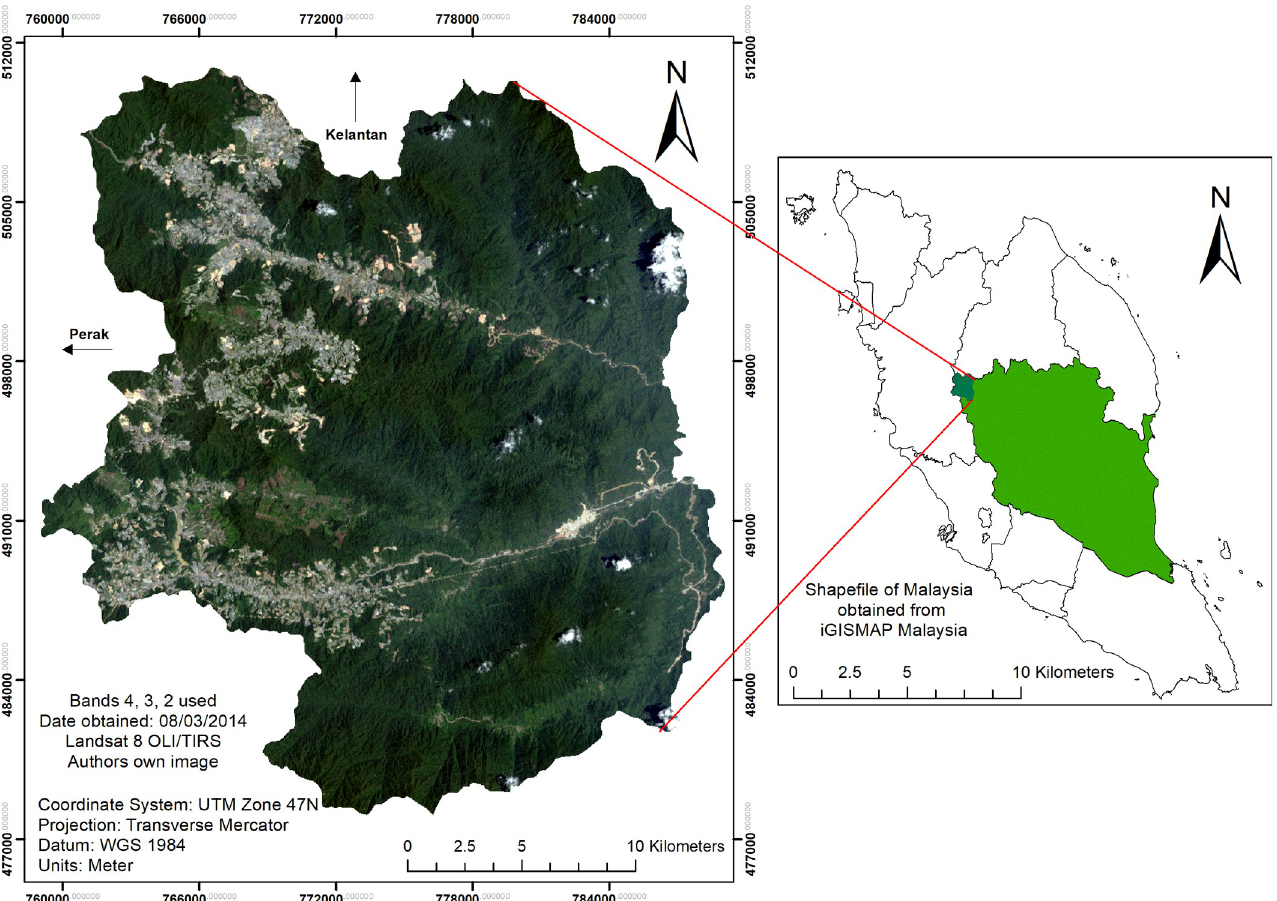
Fig 1. Study site of the Cameron Highlands District in the state of Pahang, Malaysia. (Data source: Landsat-8 OLI image courtesy of the U.S. Geological Survey).